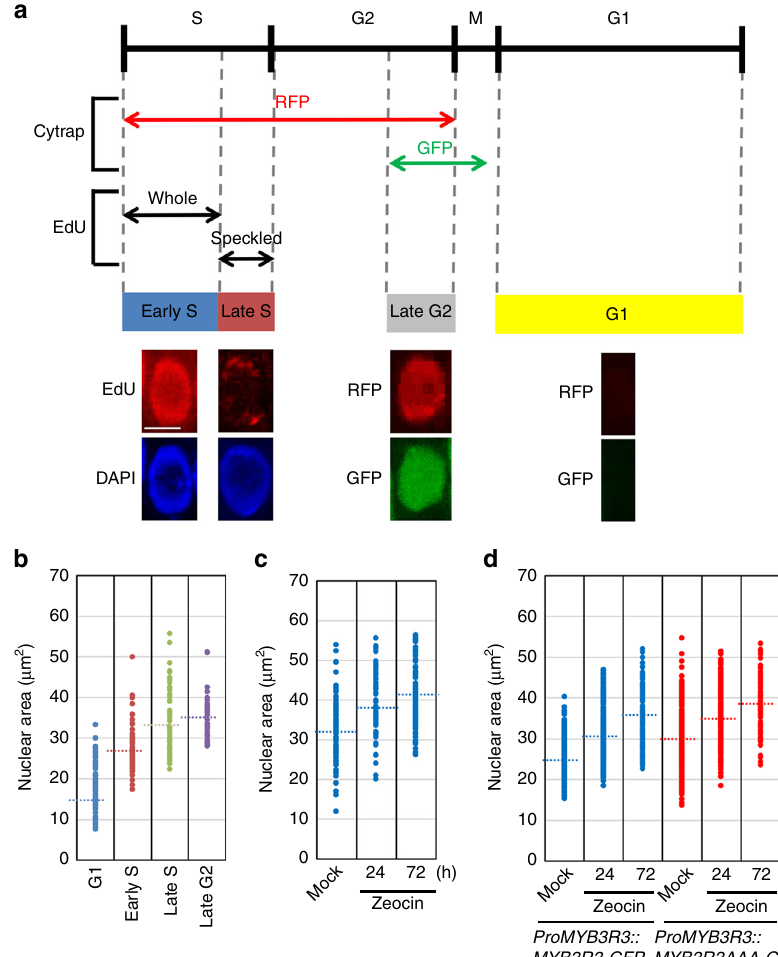
Fig. 3 Changes in nuclear area upon DNA damage. a Assignment of root meristematic cells to distinct cell cycle stages. In the Cytrap marker system, RFP and GFP fl uorescence represent cells in S-to-G2 and late G2-to-M (metaphase), respectively. EdU staining of the whole nucleus or speckled signals indicate cells in early S or late S, respectively. Representative patterns of EdU and Cytrap signals are shown for early S, late S, late G2 and G1. Scale bar , 10 μ m. b Nuclear area at distinct cell cycle stages. By using 5-day-old seedlings, cell cycle stages of cells in the root meristem were identi fi ed based on Cytrap and EdU signals as shown in a . Dotted lines indicate the average nuclear area ( n > 68). c Nuclear area of root meristematic cells after treatment with zeocin. Five-day-old WT seedlings were transferred to medium with 2 µ M zeocin and grown for 24 or 72 h. Dotted lines indicate the average nuclear area ( n > 84). d Nuclear area in the myb3r3 mutant harbouring ProMYB3R3::MYB3R3-GFP or ProMYB3R3::MYB3R3AAA-GFP . Five-day-old seedlings were transferred to medium with 2 µ M zeocin and grown for 24 or 72 h. Nuclear area of GFP-expressing cells in the root meristem was measured. Dotted lines indicate the average nuclear area ( n >